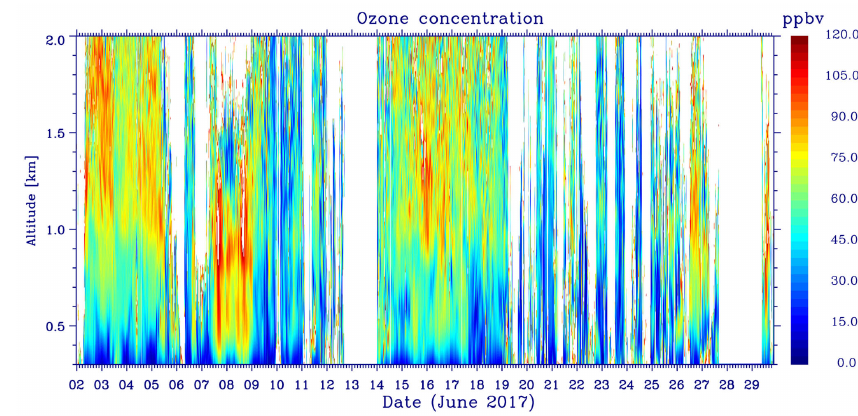
Figure 13. Time series of the vertical profiles of the O 3 concentrations measured by the ozone lidar in June 2017.